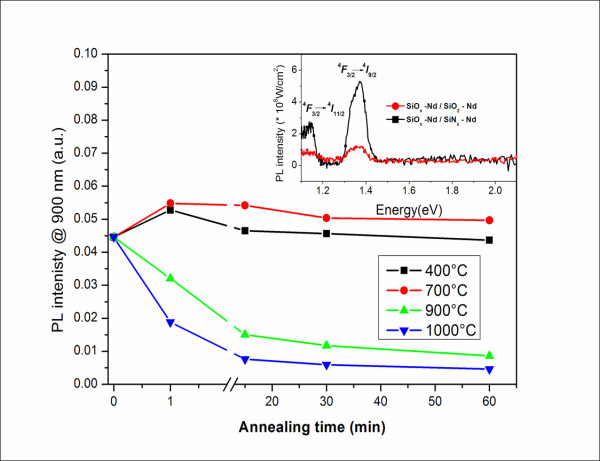
PL intensity with annealing time and temperature. Evolution of the Nd3+ PL intensity at 1.37 eV for doped SiOx/SiNy MLs with annealing temperature and time. (Inset) PL spectra of as-grown Nd3+-doped SiOx/SiNy and SiOx/SiO2 MLs with equal number of periods. The thicknesses of the SiOx, SiO2, and SiNy sublayers are 3.5, 5.0, and 5.0 nm, respectively.